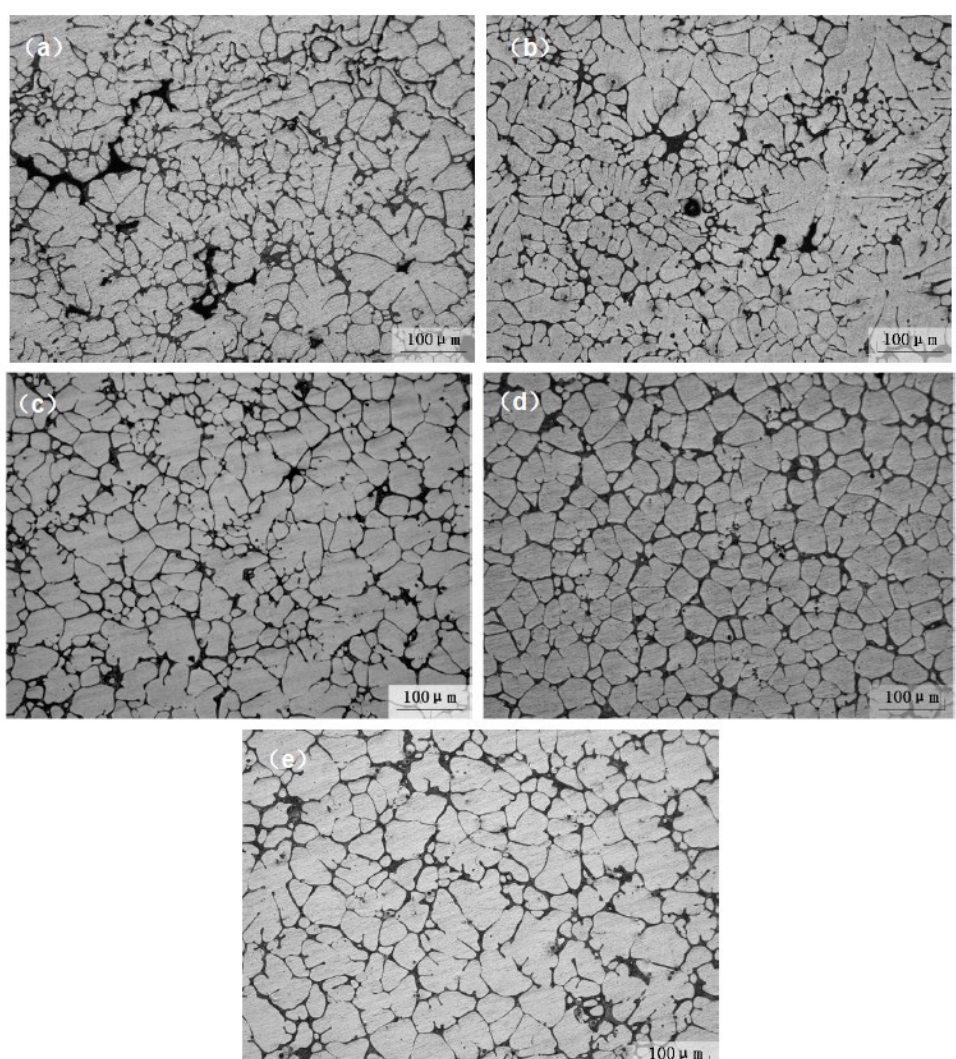
Figure 3. Microstructures of Mg-3.03Ca alloy treated with different ultrasonic treating durations. ( a ) 0 s; ( b ) 30 s; ( c ) 60 s; ( d ) 90 s; ( e ) 120 s.